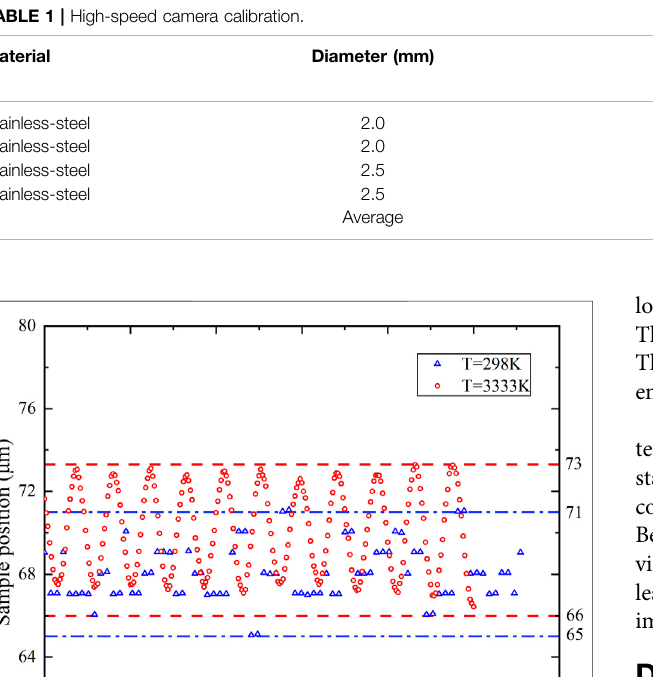
TABLE 1 | High-speed camera calibration.